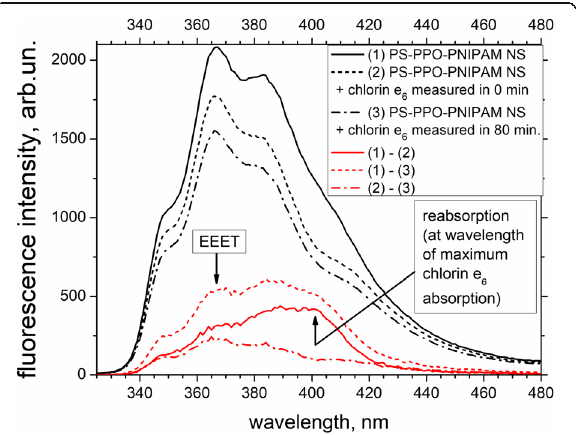
Fig. 5 Fluorescence spectra of PS-PPO-PNIPAM hybrid NS free (black solid line) and upon addition of chlorin e 6 measured in 0 min (black short-dashed line) and in 80 min (black dash-dotted line). The excitation wavelength is 250 nm. Fifty millimolars of Tris-HCl buffer, pH 7.2, is used as solvent. Differences of the spectra (solid, short-dashed and dash-dotted red lines) indicate the contribution of reabsorption and